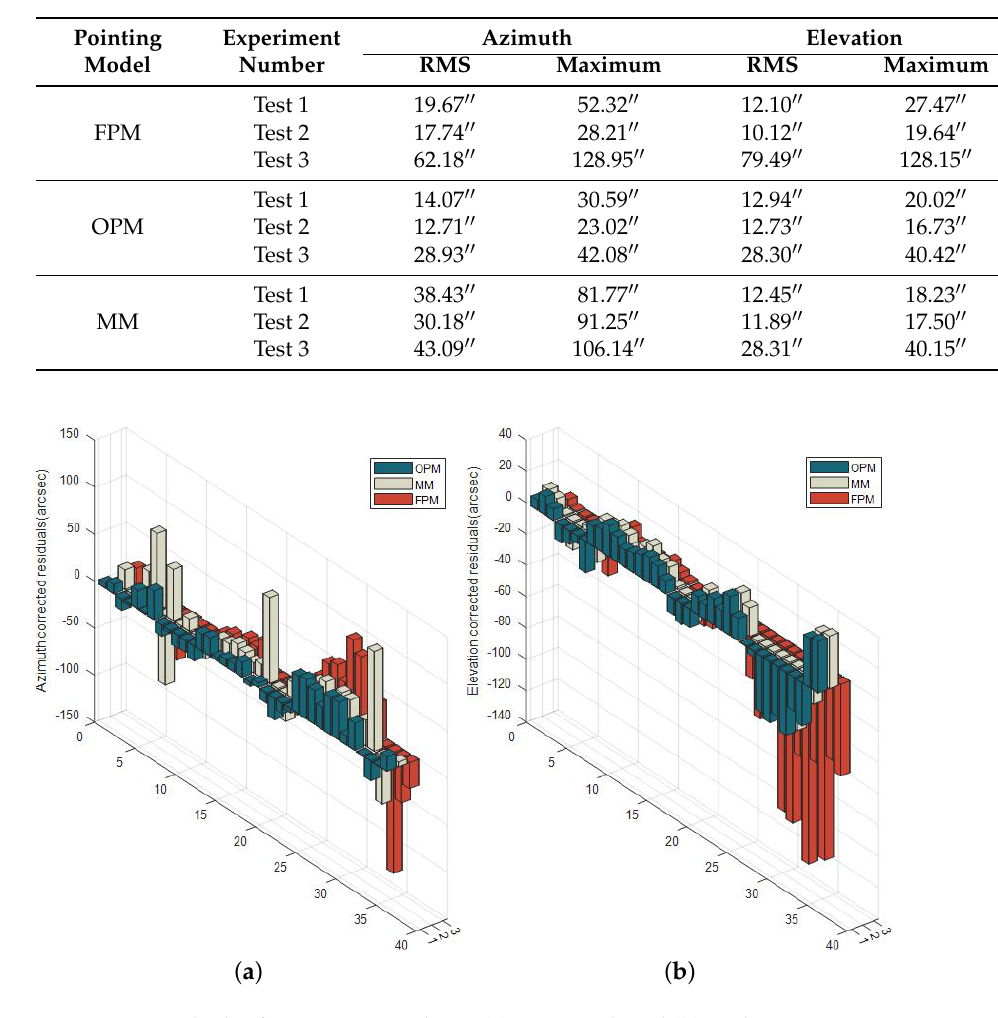
Figure 15. Residuals of FPM, OPM, and MM ( a ) in azimuth and ( b ) in